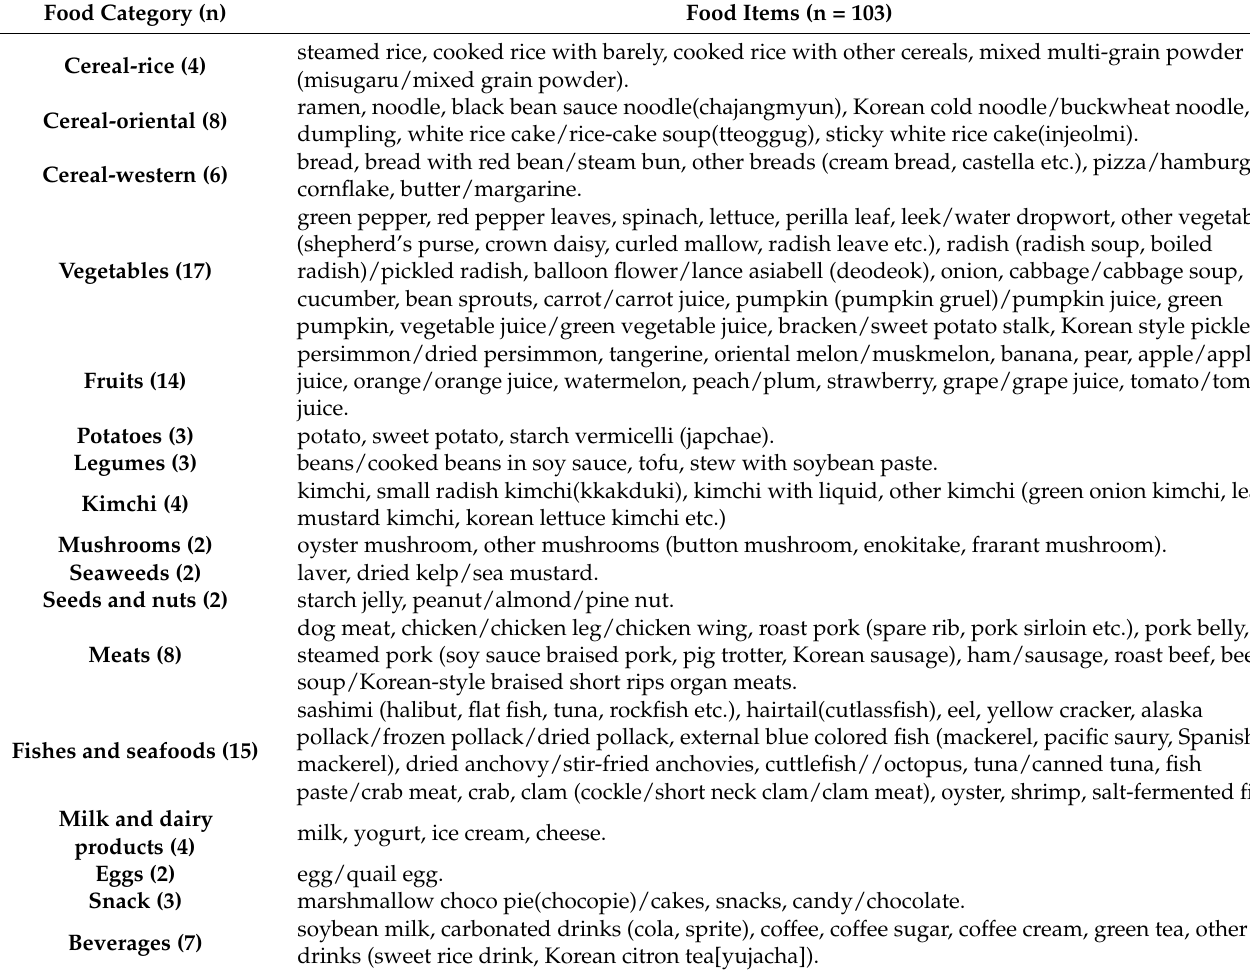
Table 1. Food items from food frequency questionnaire.